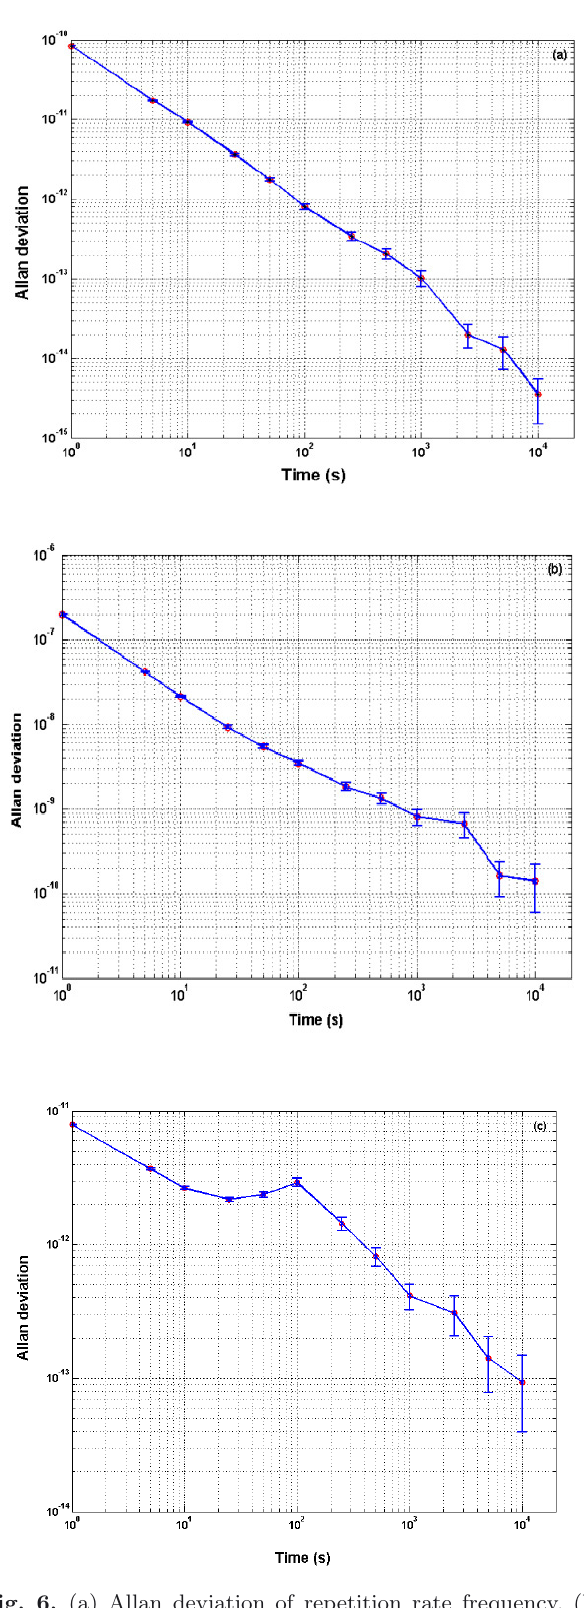
Fig. 6. (a) Allan deviation of repetition rate frequency. (b) Allan deviation carrier-envelope offset frequency. (c) Allan de- viation of f beat between CEM2 stabilized on f component and femtosecond comb.